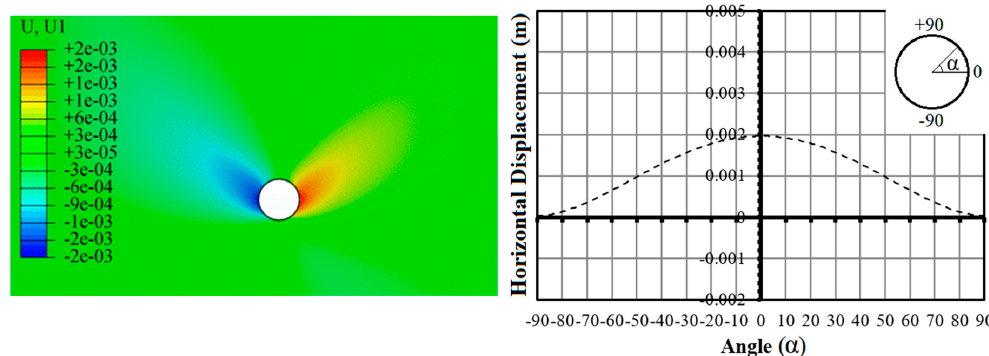
Figure 15. Displacements in the horizontal direction under transient flow conditions.